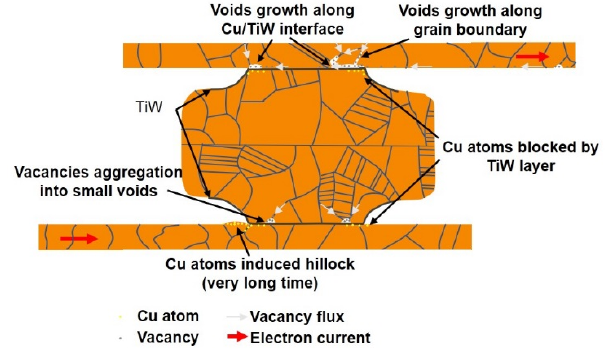
Figure 11. The relationships during the EM test among electron current direction, Cu atoms, vacancies, and TiW layers. cancies, and TiW layers. The Cu atoms and vacancies are emphasized on the anode and cathode, The Cu atoms and vacancies are emphasized on the anode and cathode, respectively. The anode and cathode are defined respectively. The anode and cathode are defined by the electron current direction and the TiW by the electron current direction and the TiW layer. Due to those mechanisms, voids and hillock can be formed.